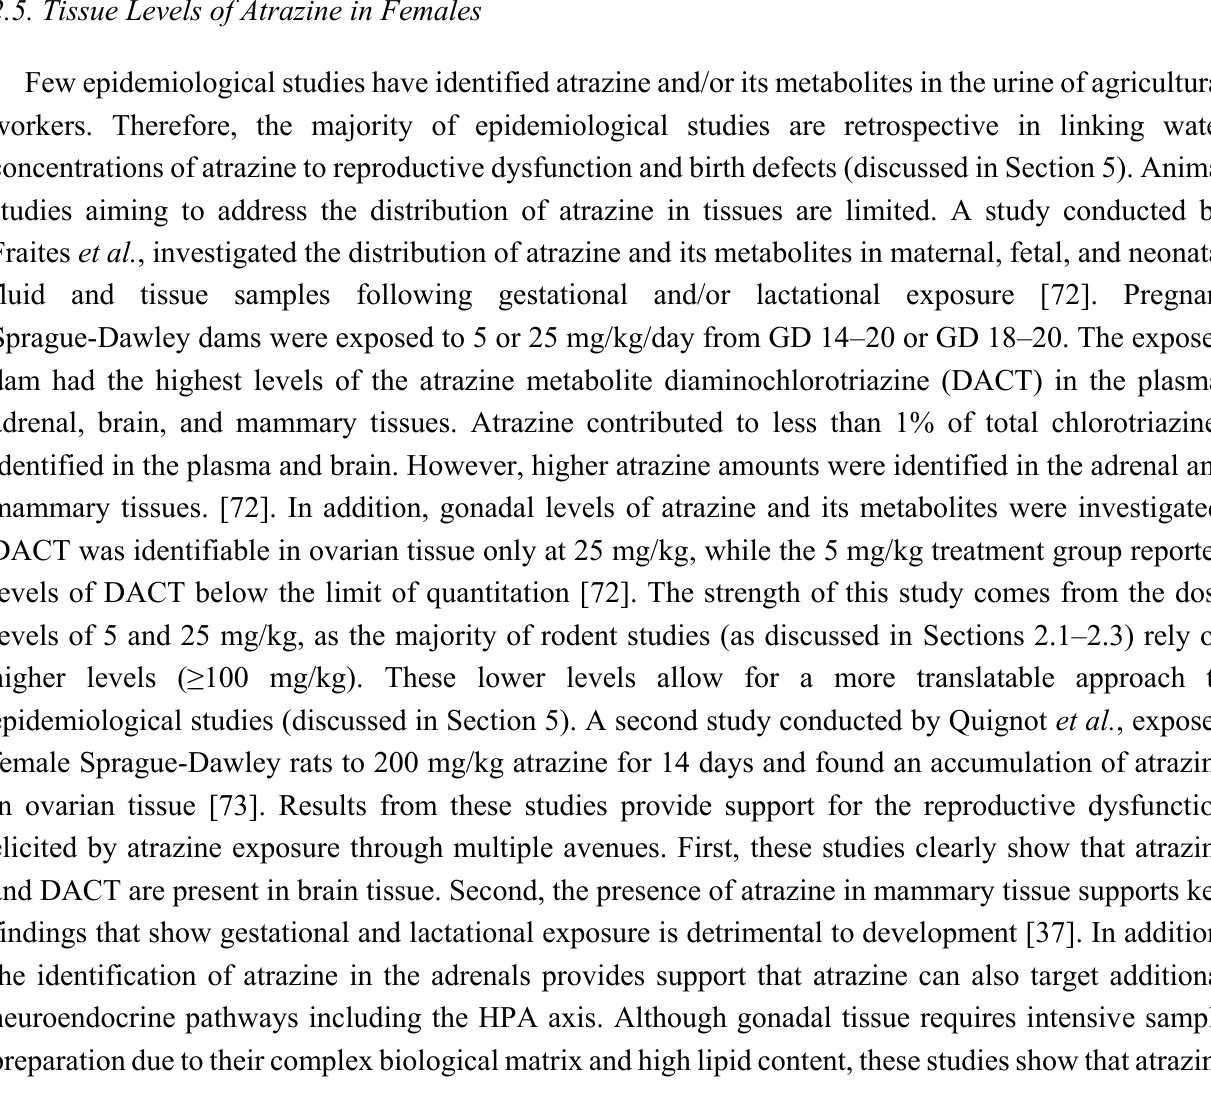
Figure 1. Working conceptual model of steroidogenesis and upstream regulators associated with atrazine exposure. This diagram represents the upstream cellular mechanisms (upstream regulators are in blue) and steroidogenic genes (in red) that are reported to be altered by atrazine exposure. All genes are included above as their human